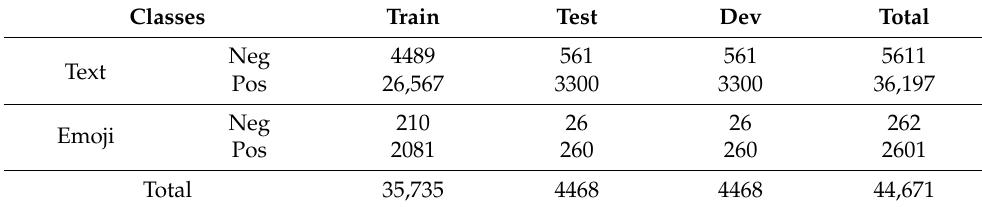
Table 3. Chinese scenic spot evaluation text dataset with emotional